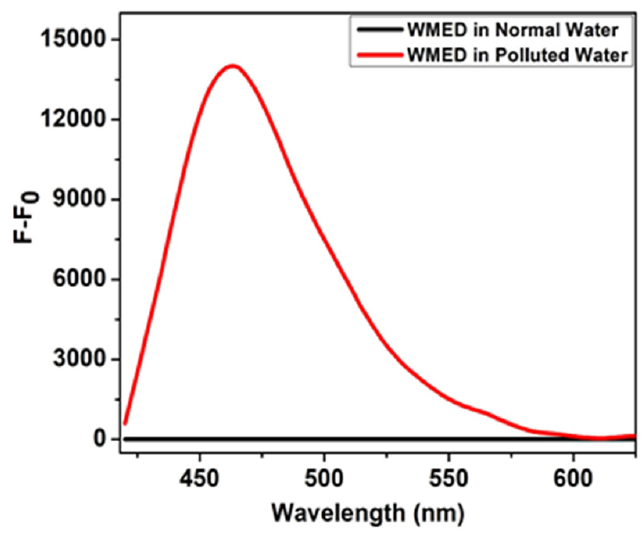
Figure 7. Fluorescence intensity of WMED in normal water (black line) and contaminated water having Pb 2+ ions (Red line).